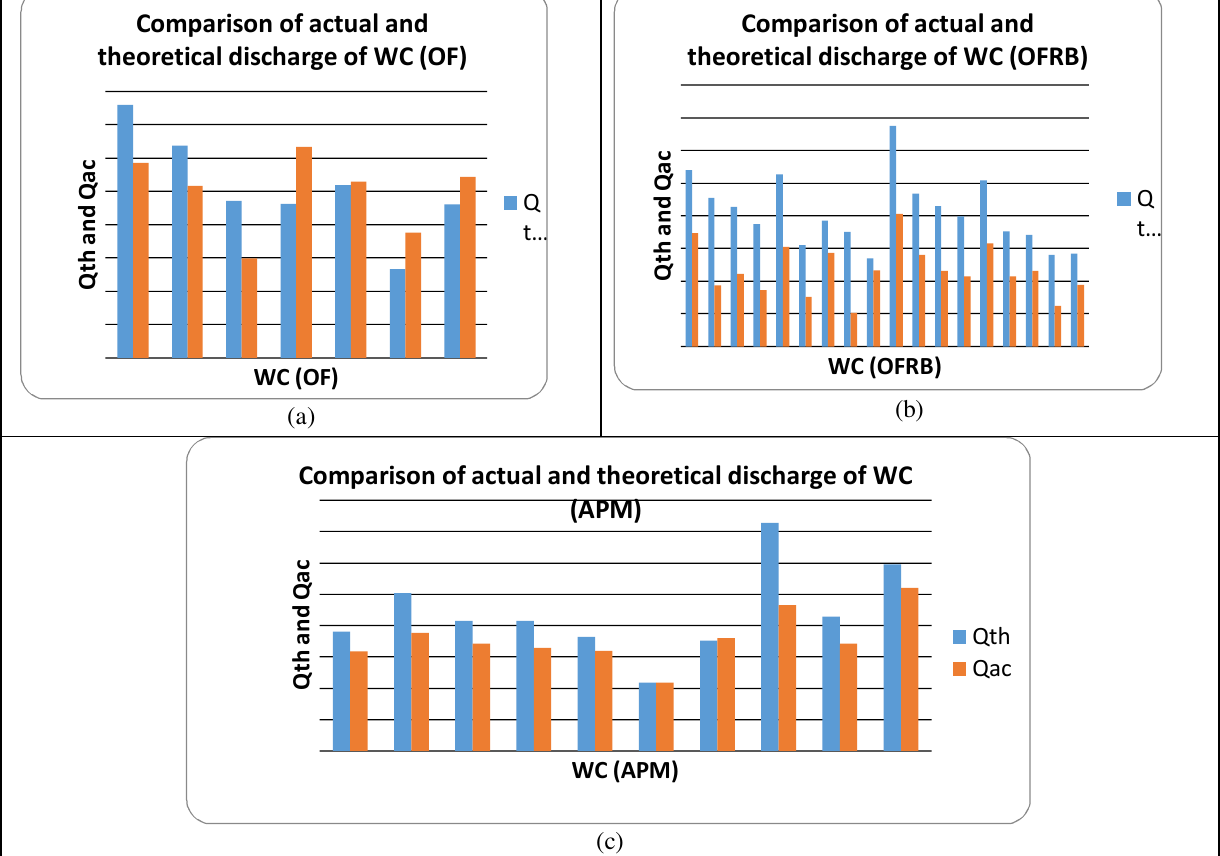
Fig.1: Field calibration of outlets along 4-R Hakra Canal for (a) OF, (b) OFRB and (c)